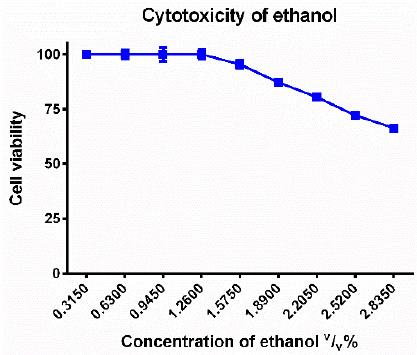
Figure 4. Cytotoxicity of ethanol measured by MTT-assay. Cell viability expressed as the percentage of the absorbance of the untreated control cells. Data expressed as mean ± SEM, n = 12. Cell viability of the samples at the different concentrations: 100% ± 0.2%; 100% ± 1.8%; 100% ± 3.1%; 100% ± 2%; 95% ± 1.7%; 87% ± 0.5%; 81% ± 1.1%; 72% ± 0.9%; 66% ± 1%.